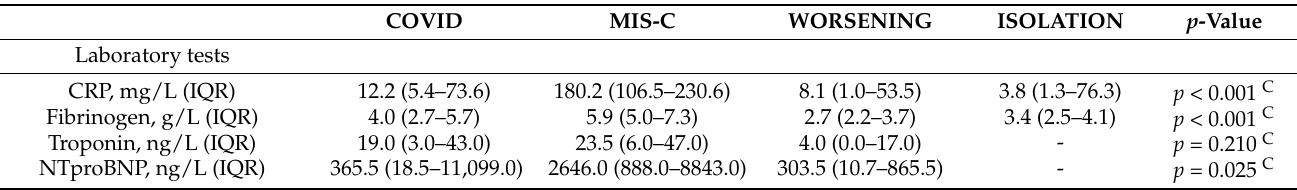
Table 3. Laboratory tests, imaging, and complementary